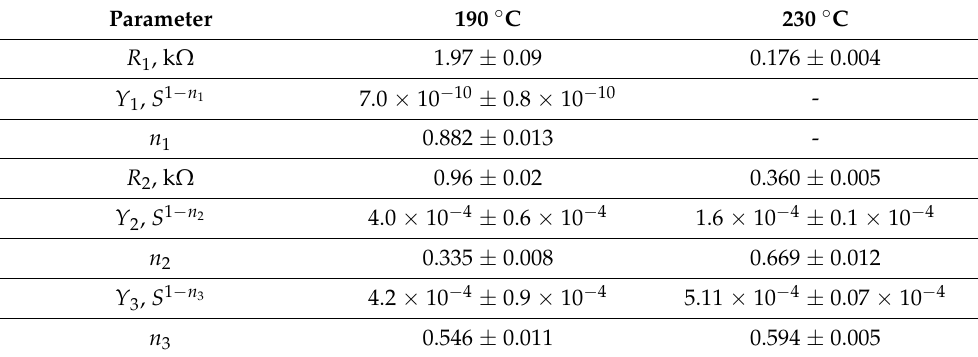
Table 2. Parameters of the equivalent circuit, R 1 , Y 10 , n 1 , R 2 , Y 20 , n 2 , Y 3 , and n 3 , determined by fitting the impedance